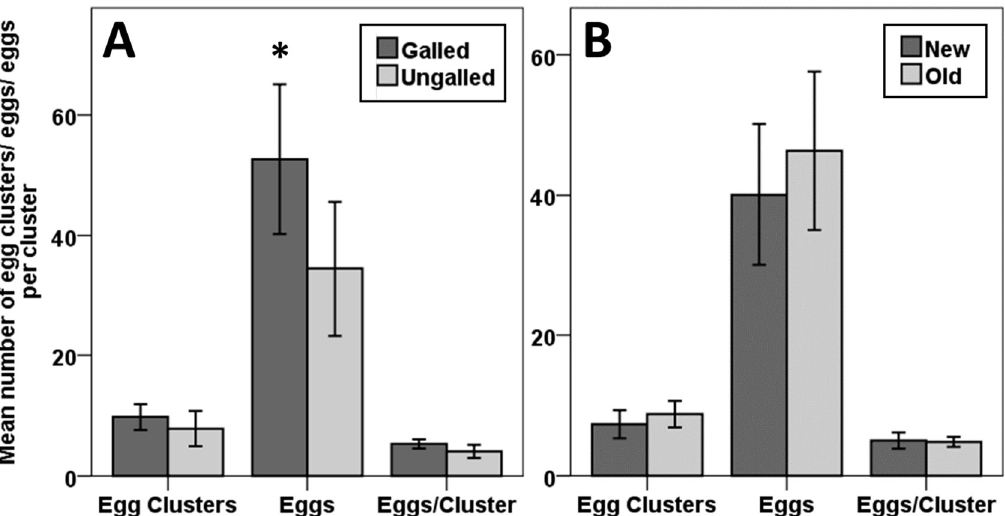
Figure 1. Mean numbers of egg clusters, individual eggs, and the mean number of eggs per cluster, laid by a single N. conspurcatalis female on ( A ) galled and ungalled L. microphyllum sprigs ( n = 30), and ( B ) young and old L. microphyllum sprigs ( n = 30). Error bars indicate standard error. Asterisks indicate significant differences.